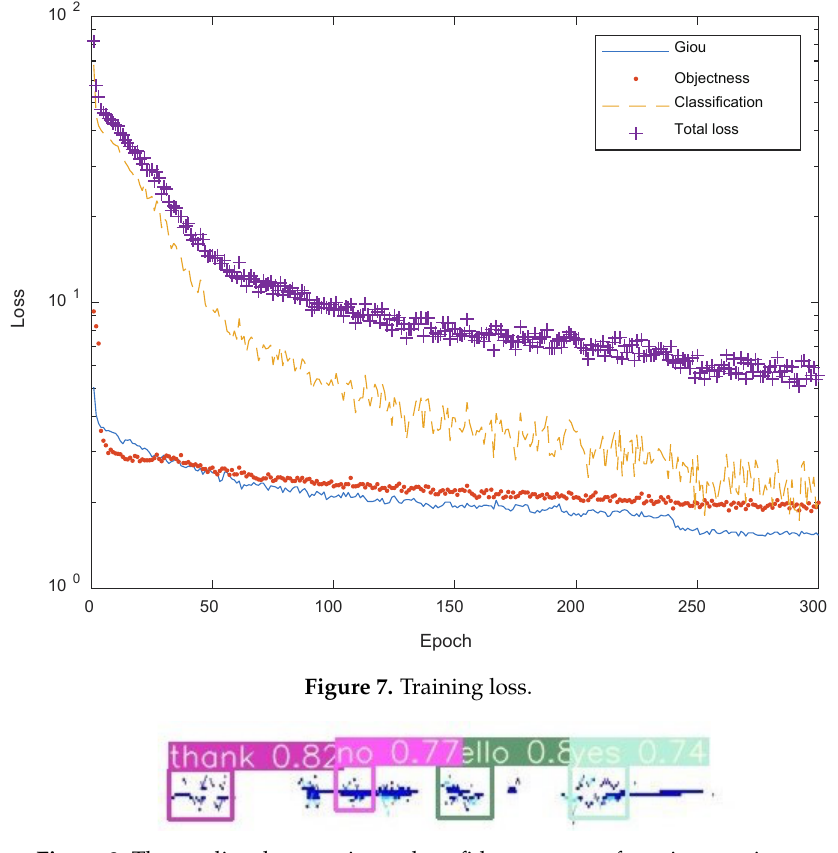
Figure 7. Training loss.